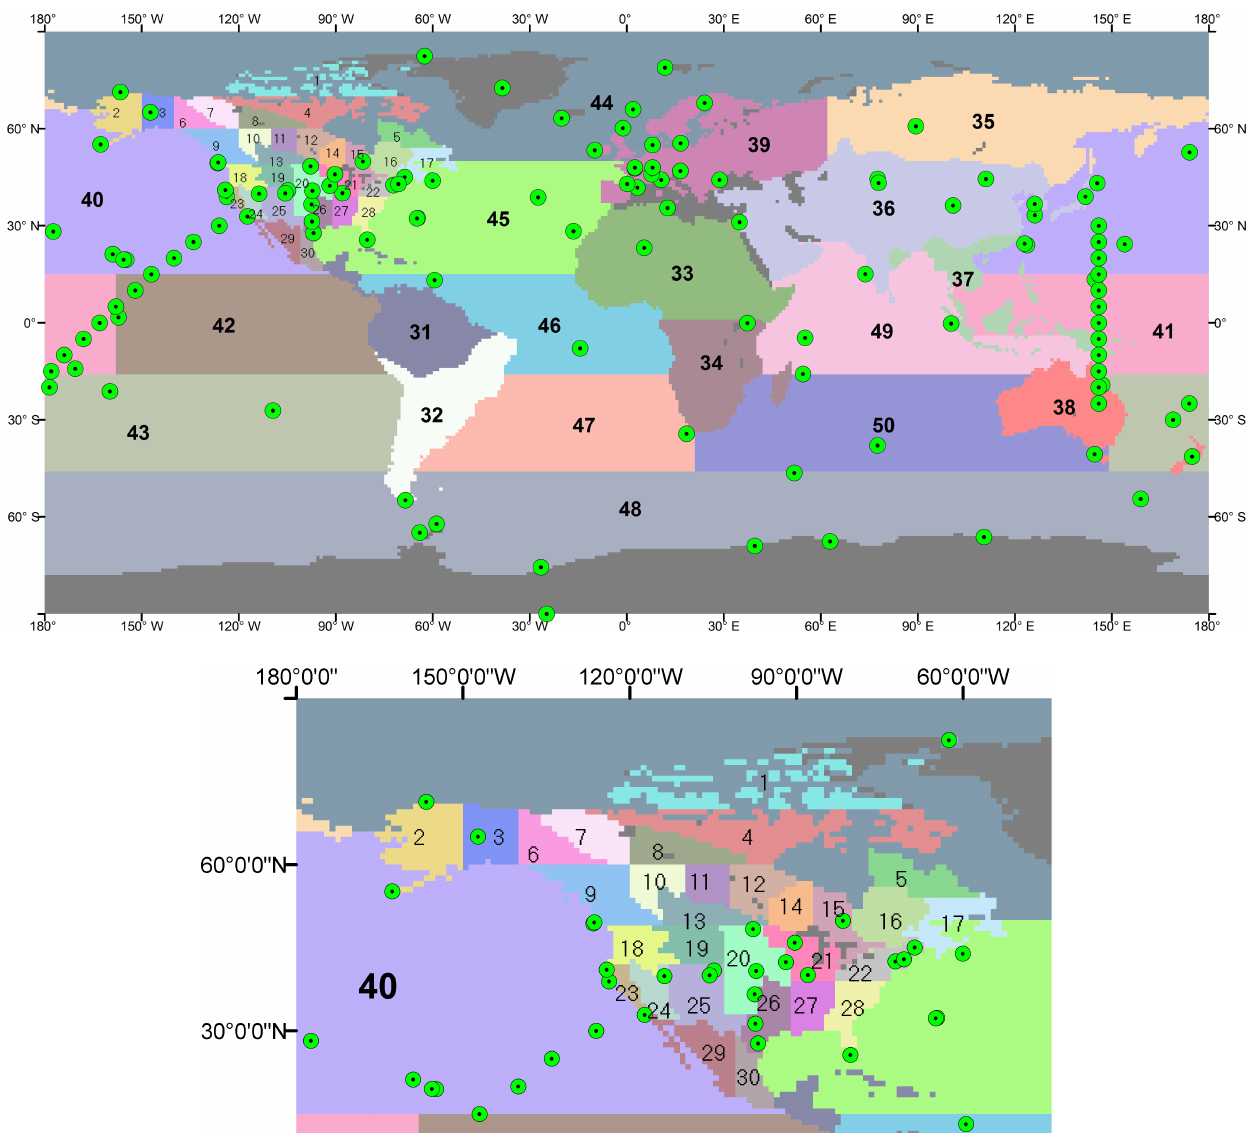
Fig. 1. An inversion scheme: 30 regions in North America and 20 regions for the rest of the globe. Locations of 209 CO 2 observational sites are also indicated. Numbers and green dot circles stand for regions and observational sites,